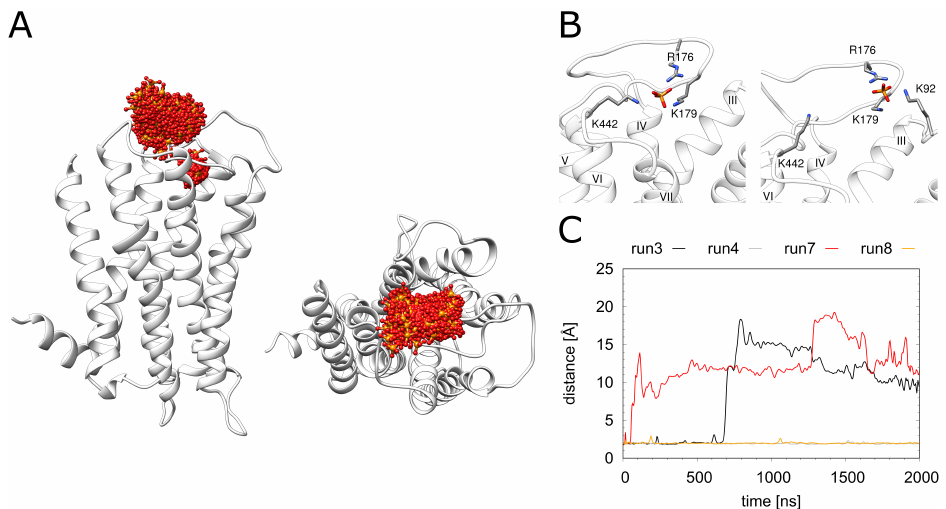
Figure 5. Dynamics of the phosphate ion. ( A ) H 1 R structure (white ribbon) depicting the phosphate position (red/orange sticks) derived from simulation at time intervals of 1 ns. ( B ) Two representative phosphate binding modes and interacting residues. ( C ) Distance between K191 5.40 and the phosphate for the H 1 R-DSP (run3, run4) and H 1 R-P (run7, run 8) simulations.